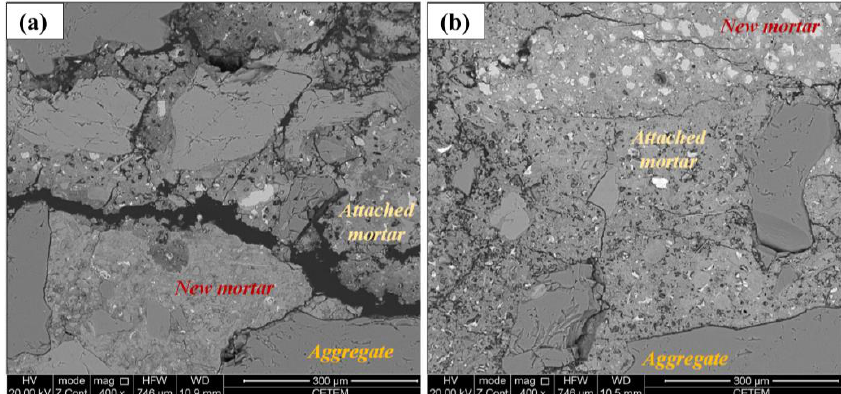
Figure 2. SEM micrographs of recycled concrete matrix ( a ) grade C25, and ( b ) grade C65, showing several microcracks after heating at 650 ◦ C. Copyright permission is taken from